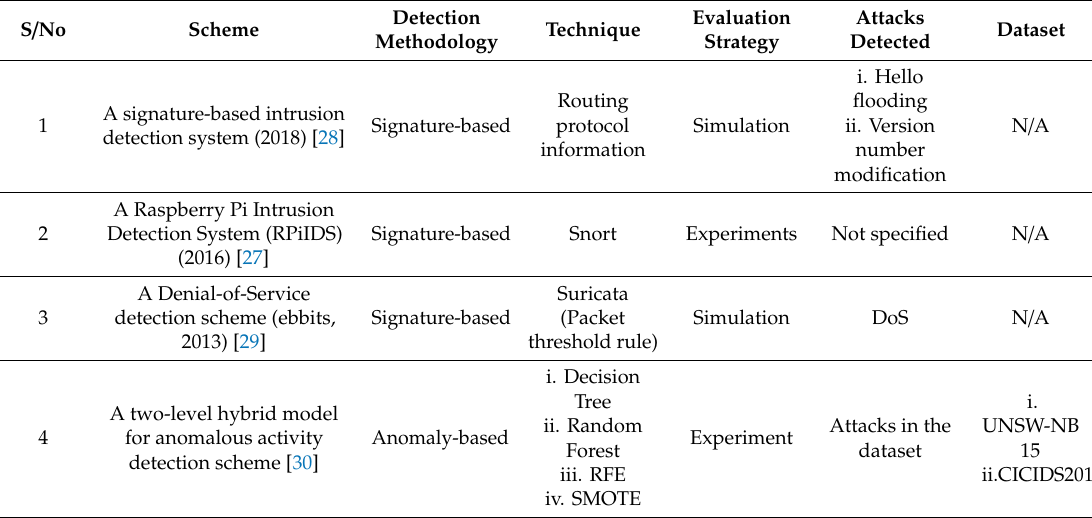
Table 1. Comparison of proposed anomaly mitigation schemes in